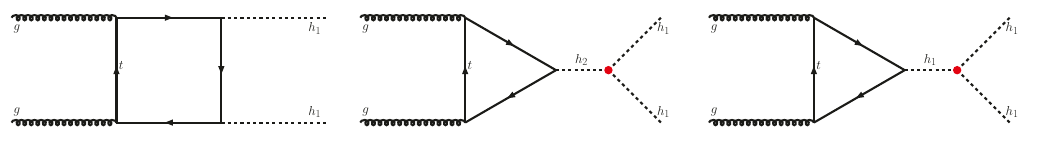
Figure 4 . Representative Feynman diagrams for Di-Higgs